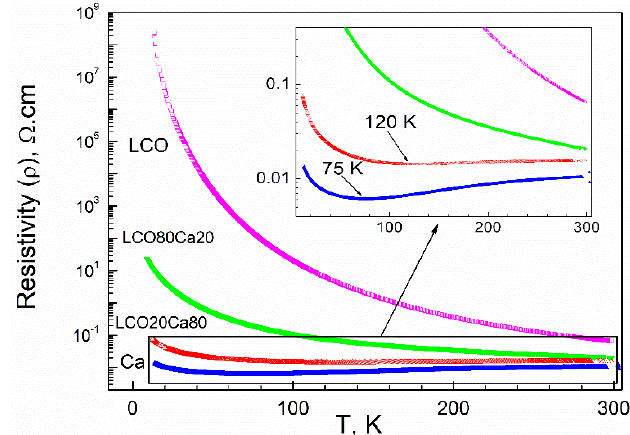
Figure 5. Temperature dependence of the electrical resistivity for the individual components (perovskite, LCO, and layered oxide, Ca) and the composites between them (LCO80Ca20 and LCO20Ca80).